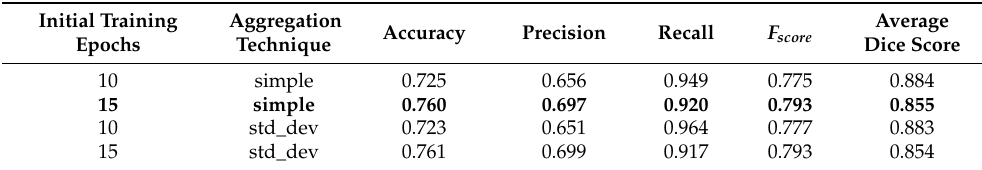
Table 6. Results of Raspberry Pi-centric federated semi-supervised transfer learning experiments. The best performance is highlighted in bold.